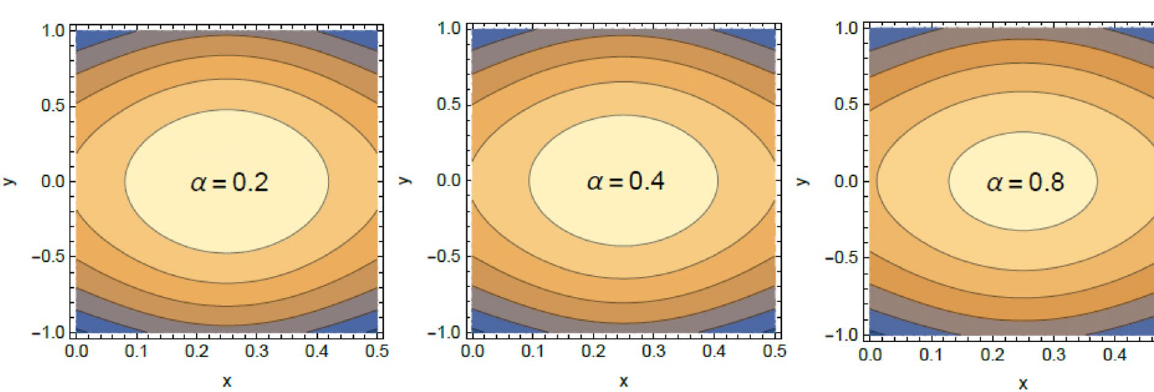
Figure 21. Contour plot of the speed for several amounts of the buoyancy ratio numeral N r .